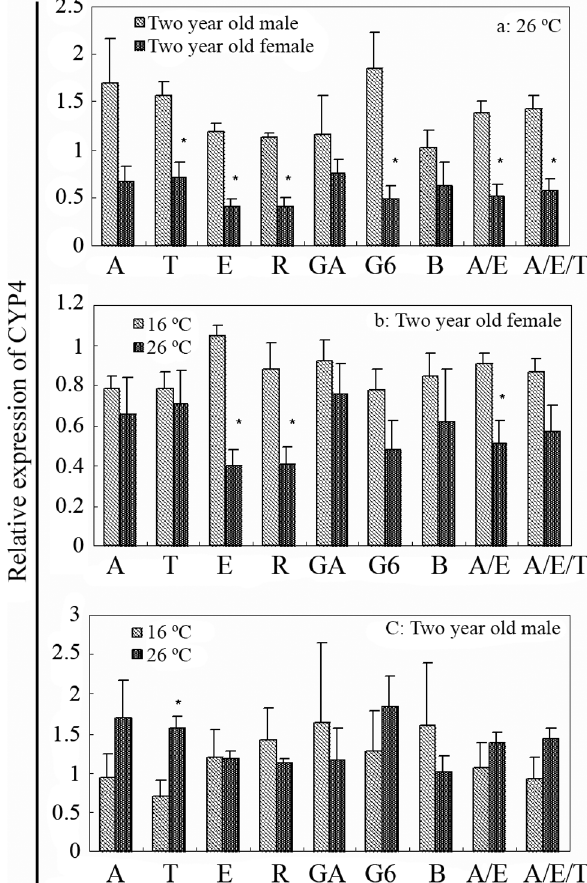
Figure 3 - Expression of CYP4T in the hepatopancreas of crucian carp. Results show the effect of (a) sex on two-year-old fish at 26 °C; (b) differ- ent temperature on two-year-old female fish; (c) different temperature on two-year-old male fish. Asterisks (*) indicate significant difference be- tween the two group (p < 0.05). Abbreviations: A - ACTB, T - TUBA, E - EEF1A, R - RPL8, GA - GAPDH, G6 - G6PDH, B - B2MG, A/E - ACTB/EEF1A, A/E/T -